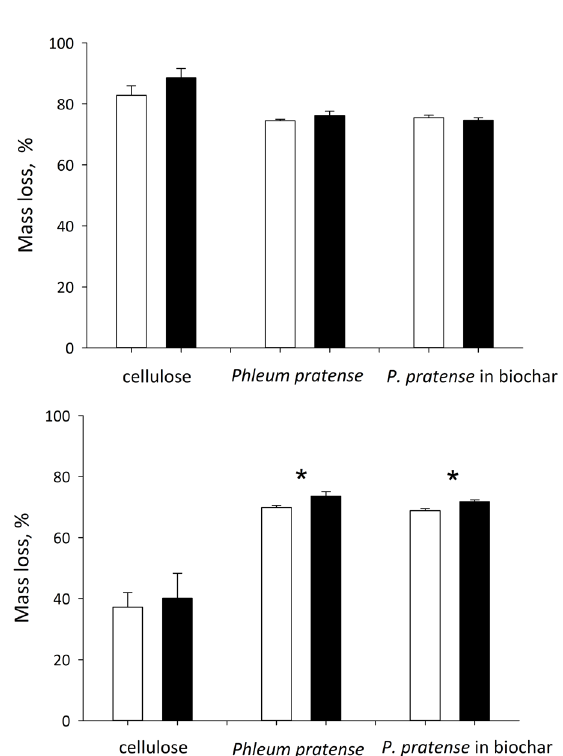
Fig. 2. Mean (+ standard error of mean) mass loss of cellulose, Phleum pratense shoots grown on the control soil and P. pratense shoots grown on biochar amended sandy till (upper, n = 6) and medium fine sand soils (lower, n = 5). White bars indicate control soil and black bars indicate biochar amended soil. * = statistically significant difference ( p < 0.05) between biochar